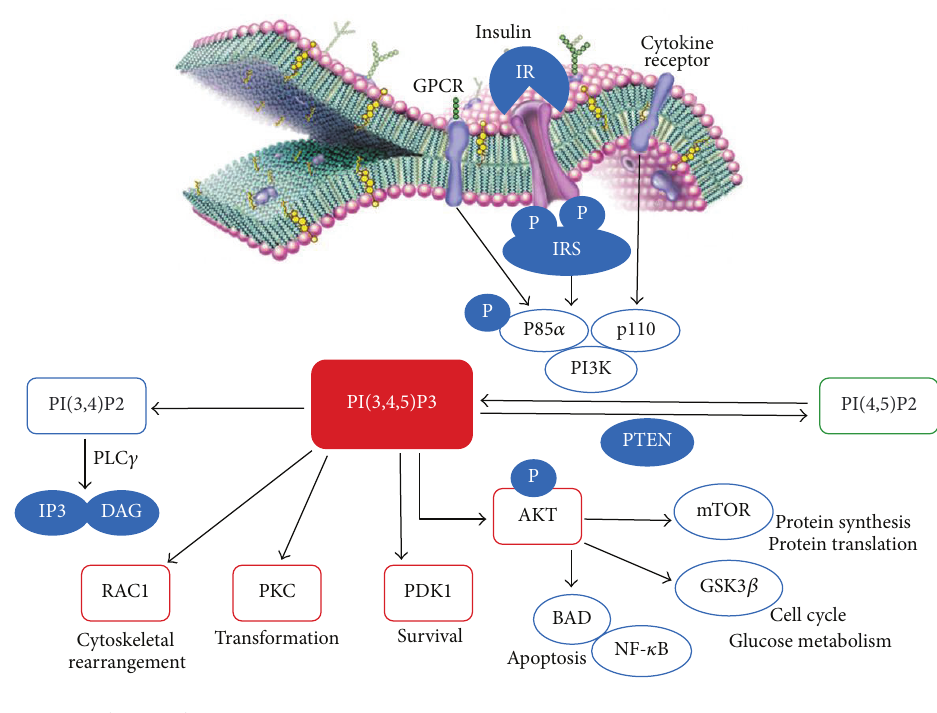
Figure 2: Insulin receptor and phosphatidylinositol (3,4,5)-trisphosphate formation. The activation of PI3K by insulin, G-protein coupled receptor, or growth factors generates different 3 󸀠 phosphorylated inositol products which in turn recruit effector molecules regulating many cellular functions involved in cells survival and metabolism. GPCR: G-protein coupled receptor; IR: insulin receptor; IRS: insulin receptor substrate; PI3K: phosphatidylinositol 3-kinase; PI(4,5)P2: phosphatidylinositol 4,5-bisphosphate; PI(3,4,5)P3: phosphatidylinositol 3,4,5- triphosphate; PI(3,4)P2: phosphatidylinositol 3,4-bisphosphate; PLC 𝛾 : Phospholipase C 𝛾 ; IP3: inositol trisphosphate; DAG: diacylglycerol; PKC: protein kinase C; PTEN: phosphatase and tensin homolog; Akt: protein kinase B; RAC1: Ras-Related C3 Botulinum Toxin Substrate 1; PDK1: phosphoinositide dependent protein kinase-1; mTOR: mammalian target of rapamycin; GSK3 𝛽 : glycogen synthase kinase 3; NF- 𝜅 B: nuclear factor 𝜅 B; BAD: Bcl2-Antagonist of cell